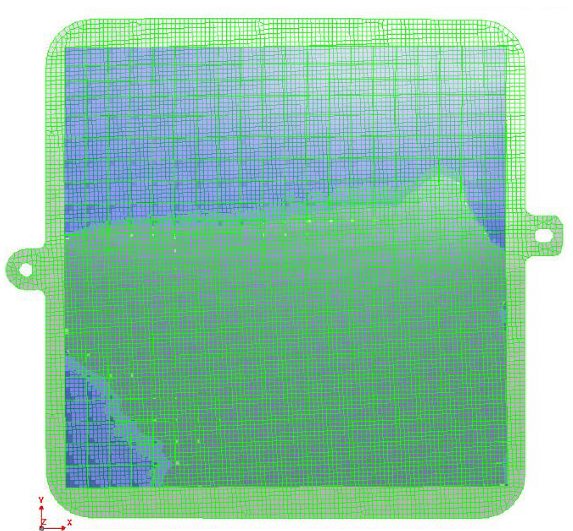
Figure 5. Example of surface superposition of simulated (green mesh) and real hydroformed piece (blue mesh), employed to measure the distance (deviation) between nodes of the grid.